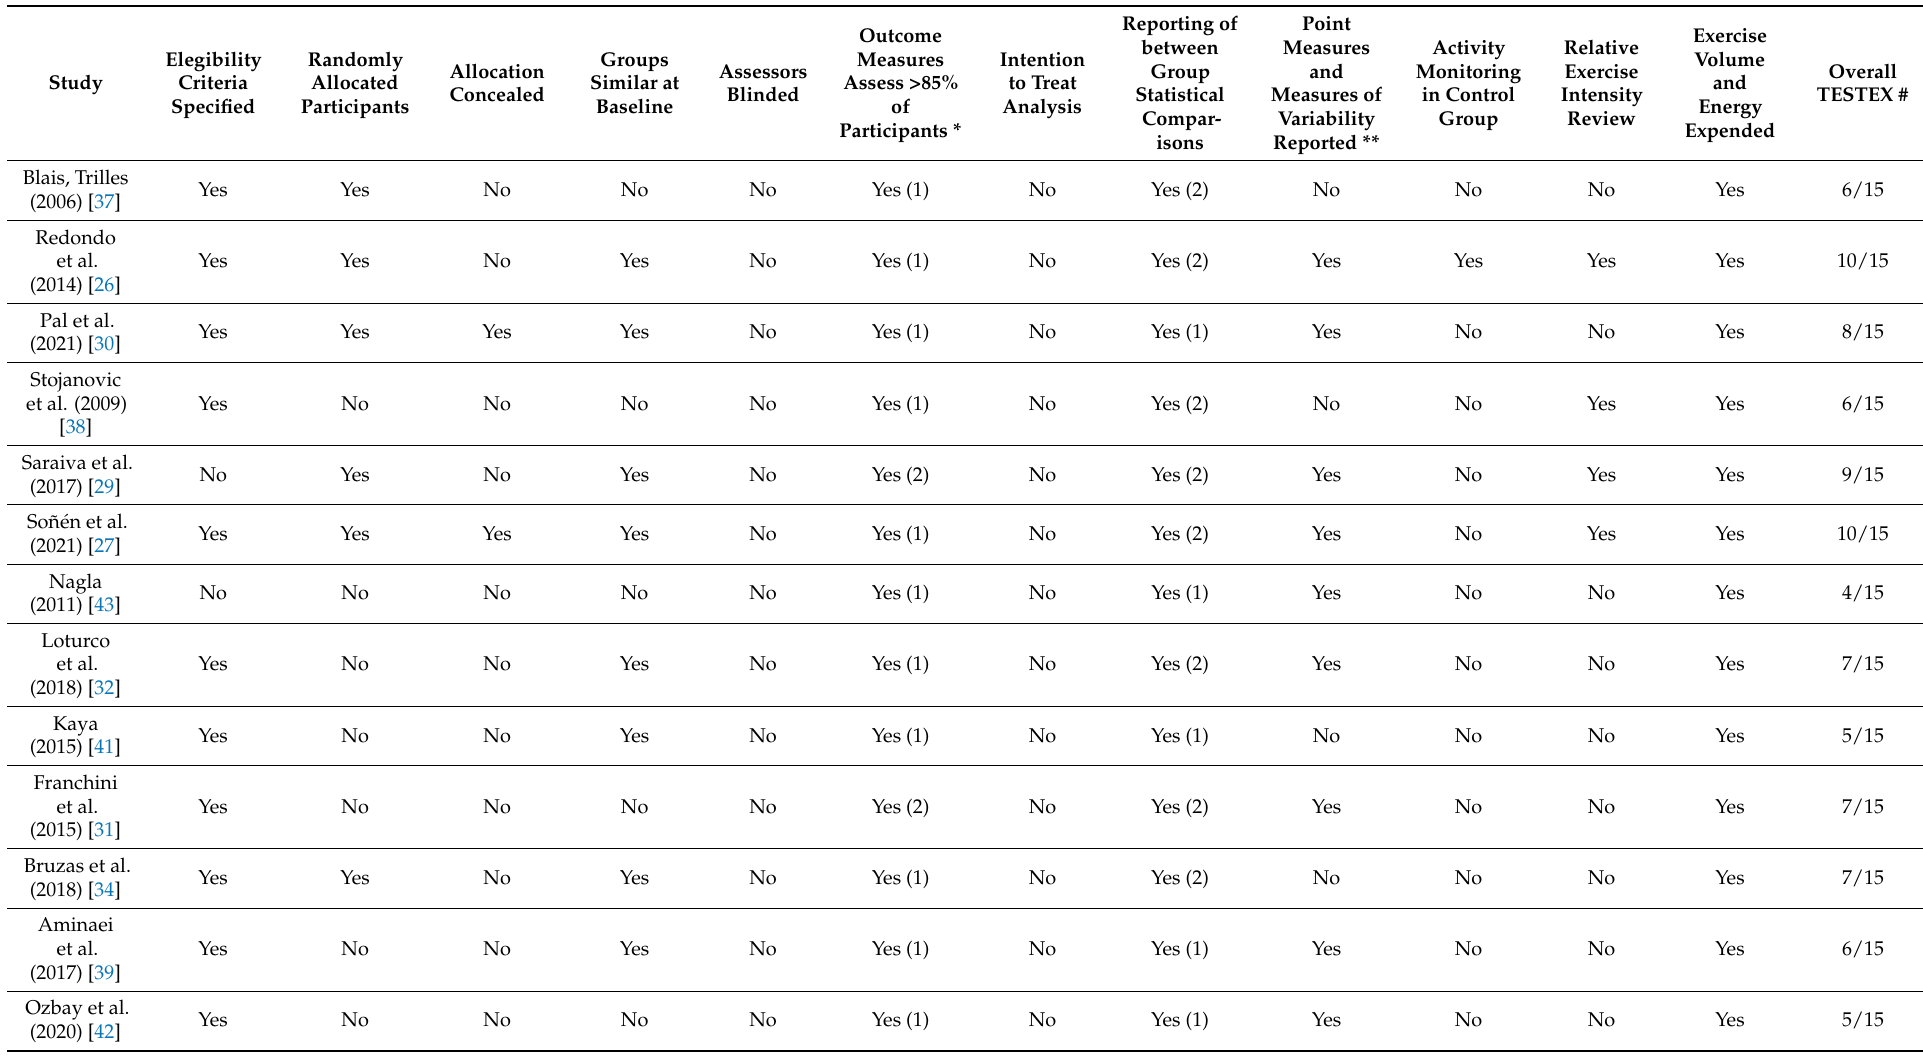
Table 1. Study quality assessment according to TESTEX